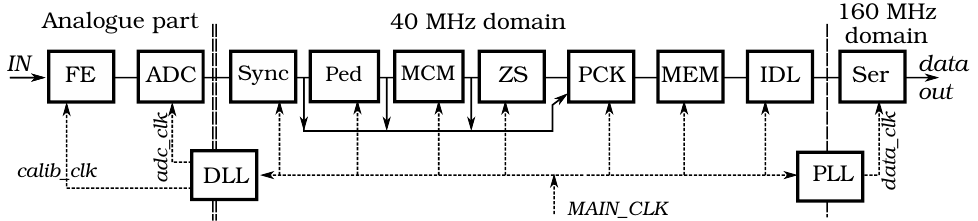
Figure 5. Data processing in the SALT; vertical lines separate clock domains; FE—analogue front- end, ADC—Analog-to-Digital Converter, Ped—Pedestal Subtraction, MCM—Mean Common